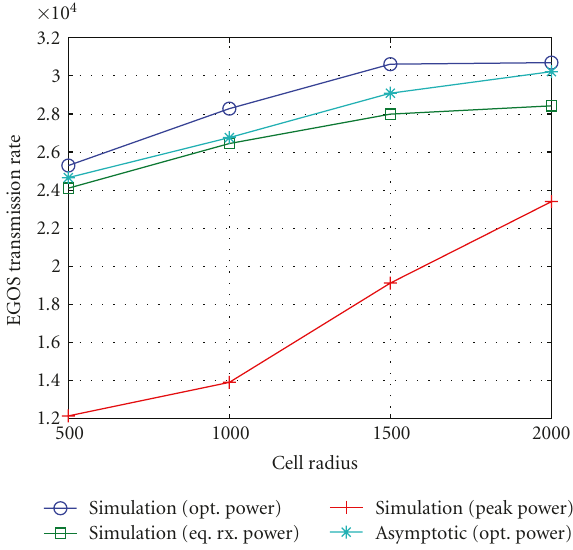
Figure 6: Finite-system EGOS rates for di ff erent cell radiuses when w = 20 kHz.